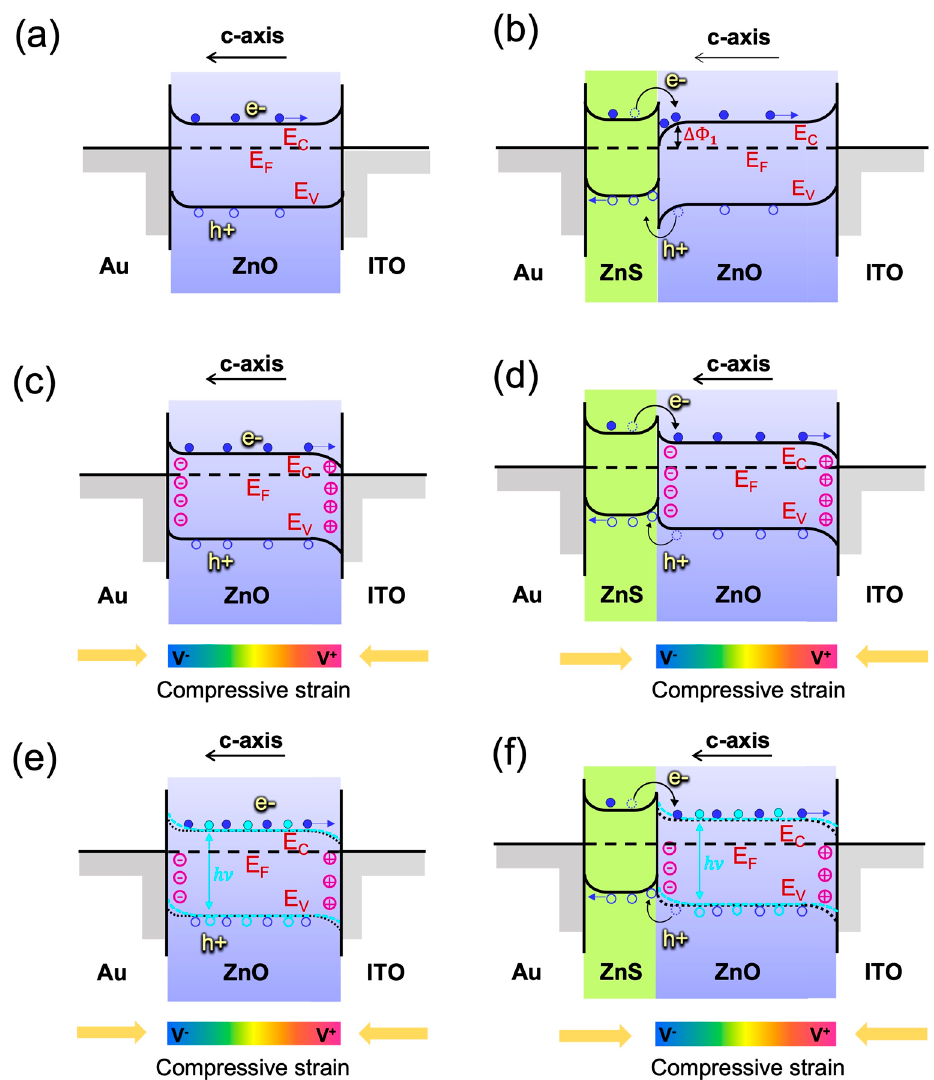
Figure 6. Energy-band diagrams of the ZnO NW and ZnO/ZnS core/shell NW devices ( a , b ) without strain and ( c , d ) with compressive strain ( e , f ) under simultaneous application of compressive strain and UV illumination, respectively.